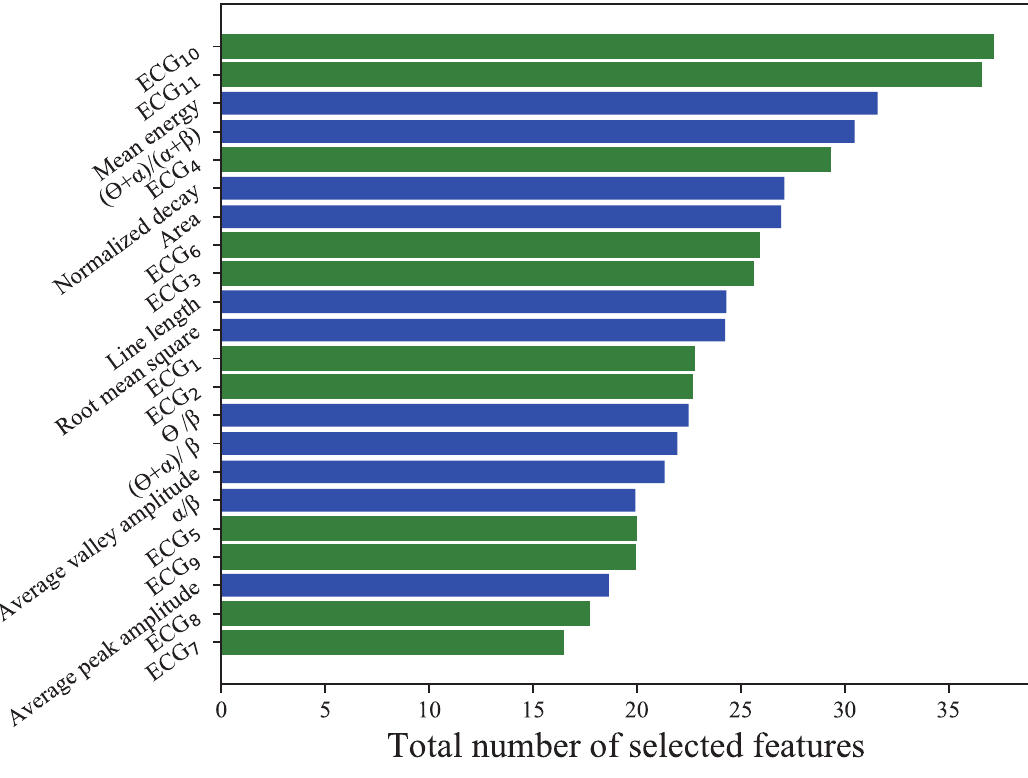
Figure 7. Total number of selected features by the DQN agent for all 11 subjects. Green bars represent the results of the 11 ECG features extracted with deep-ECGNet, and blue bars illustrate those of the 11 EEG features extracted by conventional feature engineering. ECG n denotes the ECG features extracted using